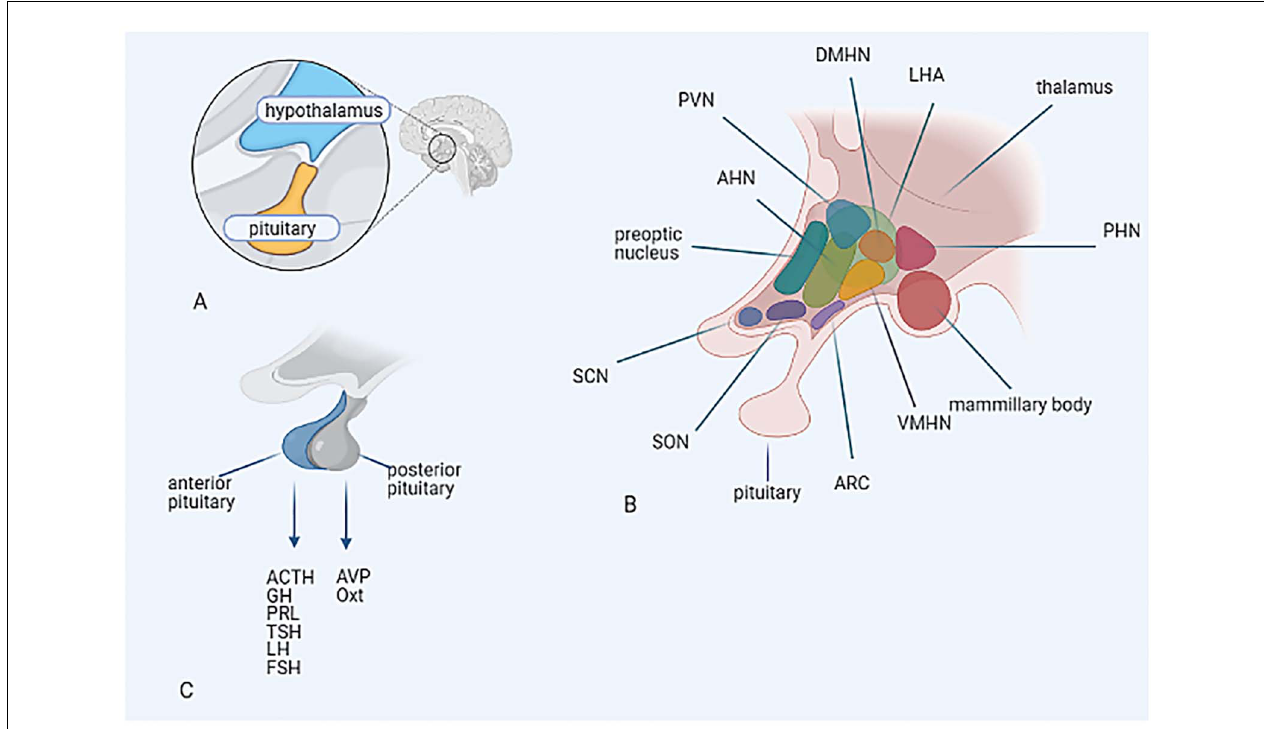
FIGURE 3 | (A) Anatomical characterization of the hypothalamus and the pituitary. (B) Structural organization of the hypothalamic nuclei. (C) Hypothalamic control of hormonal output of the pituitary. Hypothalamic nuclei: AHN, anterior hypothalamic nucleus; ARC, arcuate nucleus; DMHN, dorsomedial hypothalamic nucleus; LHA, lateral hypothalamic area; PHN, posterior hypothalamic nucleus; PVN, paraventricular nucleus; SCN, suprachiasmatic nucleus; SON, supraoptic nucleus; VMHN, ventromedial hypothalamic nucleus. Pituitary hormones: ACTH, adrenocorticotropic hormone; AVP, arginine vasopressin; FSH, follicle-stimulating hormone;